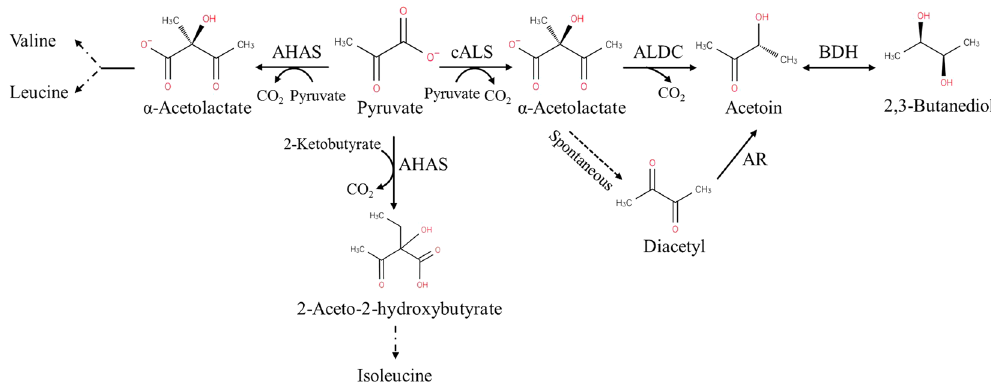
Figure 1. Scheme of the anabolic and catabolic pathways starting with pyruvate. In the figure: AHAS, anabolic acetohydroxyacid synthase; cALS, catabolic α -acetolactate synthase; ALDC, α -acetolactate decarboxylase; BDH, 2,3-butanediol dehydrogenase; and AR, diacetyl